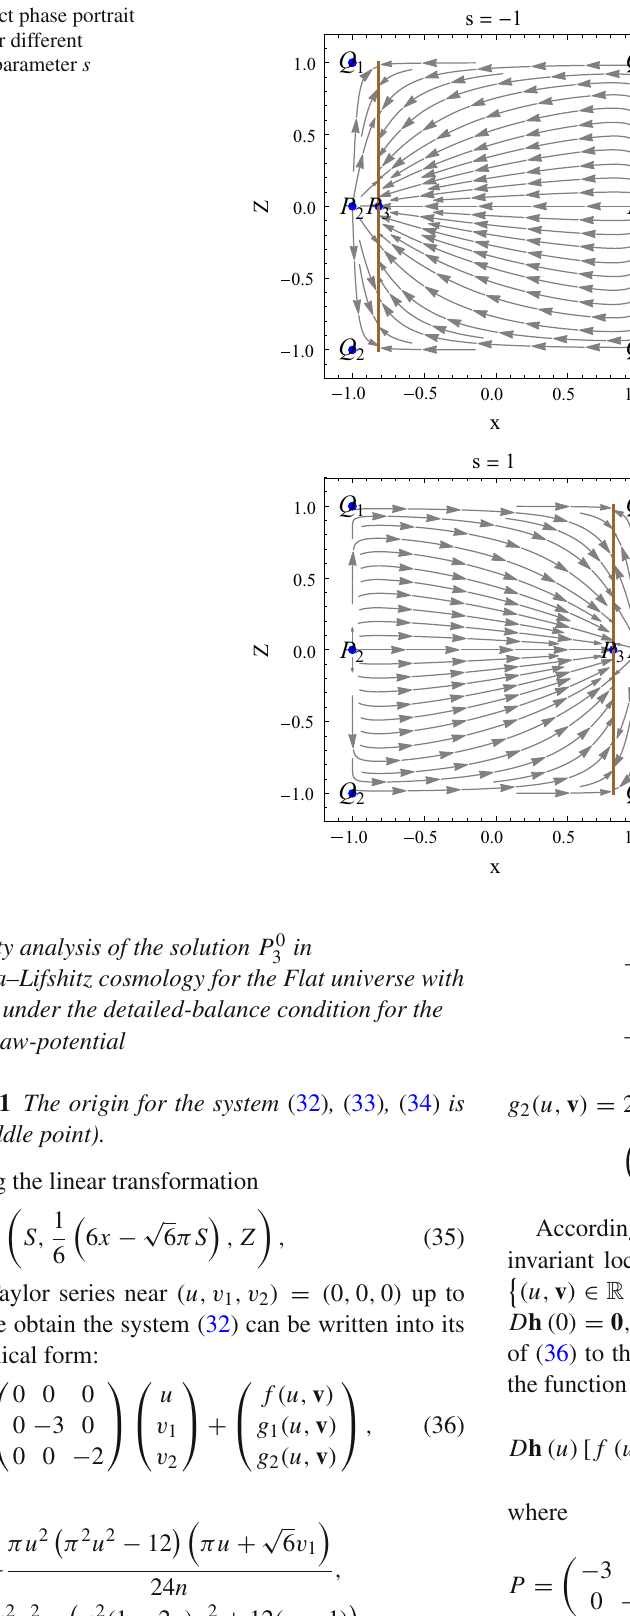
Fig. 1 Compact phase portrait of (28), (29) for different choices of the parameter